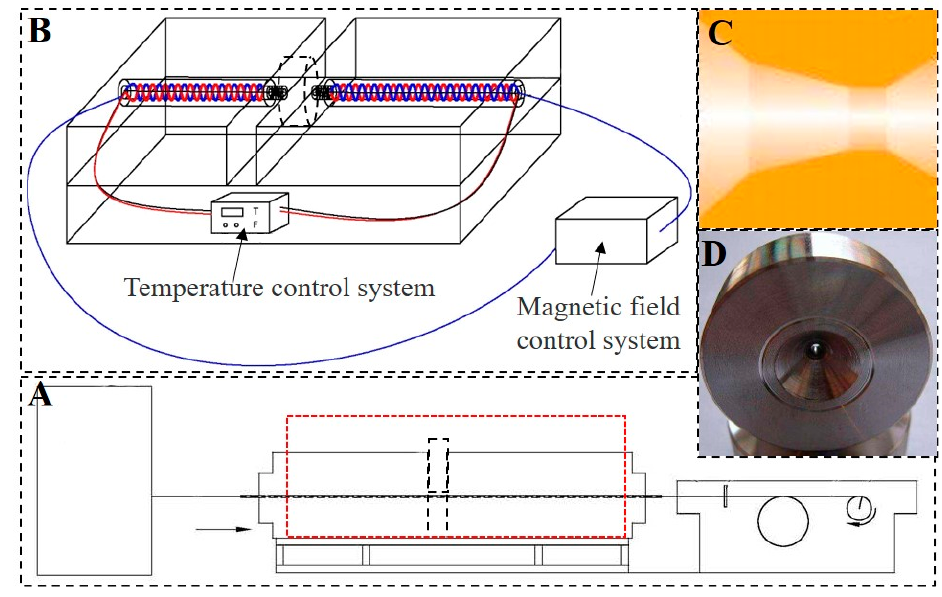
Figure 1. The structure of self-made hot-magnetic drawing device. ( A ): the whole structure of sample drawing equipment; ( B ): the part of hot-magnetic drawing; ( C ): section structure of drawing die; ( D ): drawing die.